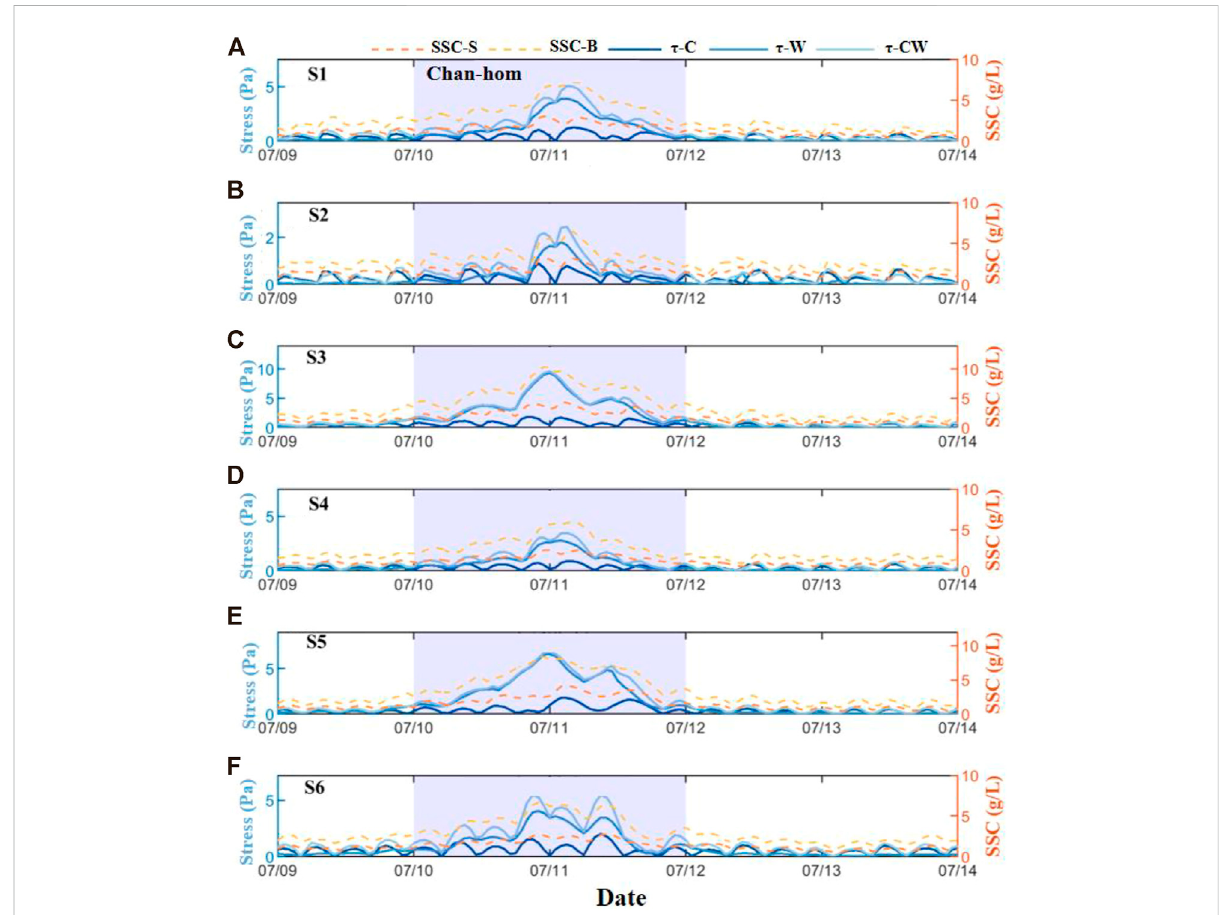
FIGURE 10 Comparison between SSC and bottom stress from July 9 to 14 July 2015 at stations (A – F) stations S1 to S6, respectively. SSC-S, surface SSC; SSC-B, bottom SSC; τ -C, current-induced bottom stress; τ -W, wave-induced bottom stress; τ -CW, combined wave- and current-induced bottom